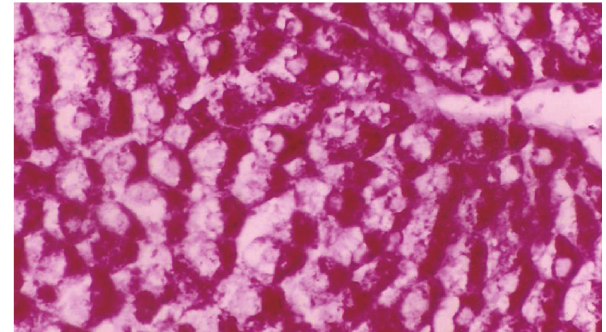
Figure 9: Photomicrograph of liver section of normal rat offspring after one week of birth ( × 400).